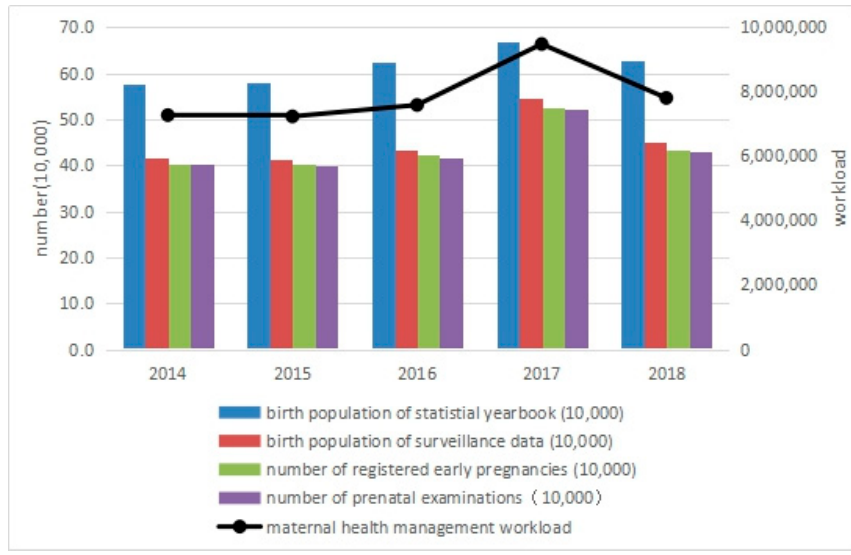
Figure 2. Maternal health management workload in Zhejiang Province, 2014–2018.